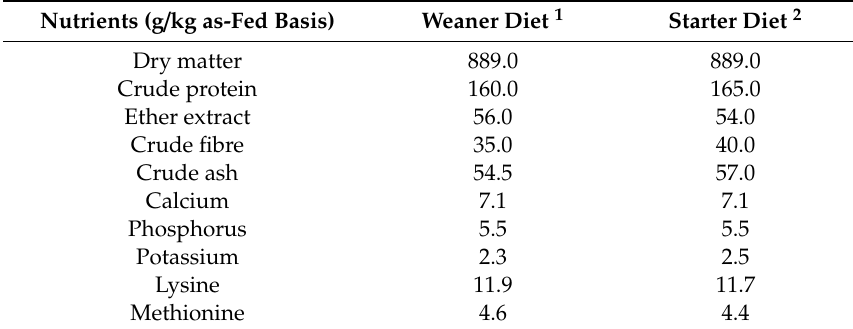
Table 1. Chemical composition (calculated) and ingredients of the weaner and starter diet, fed to piglets from d0–d14 and d14–42 post-weaning,